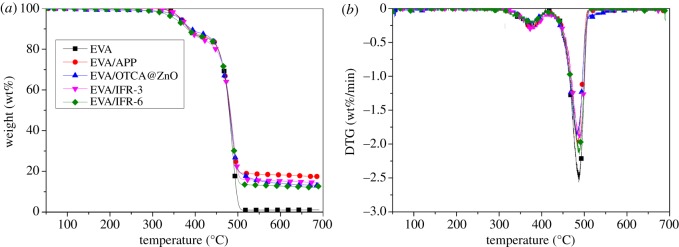
TGA (a) and DTG (b) curves of EVA and EVA composites under N2 atmosphere.